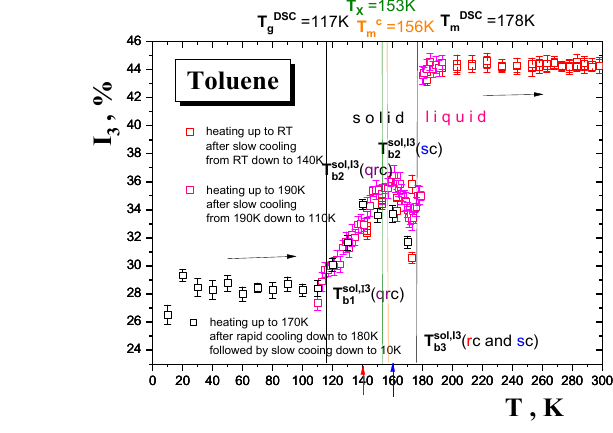
cooling with cooling rate of − 20 K/min followed by heating with heating rate of +10 K/min together